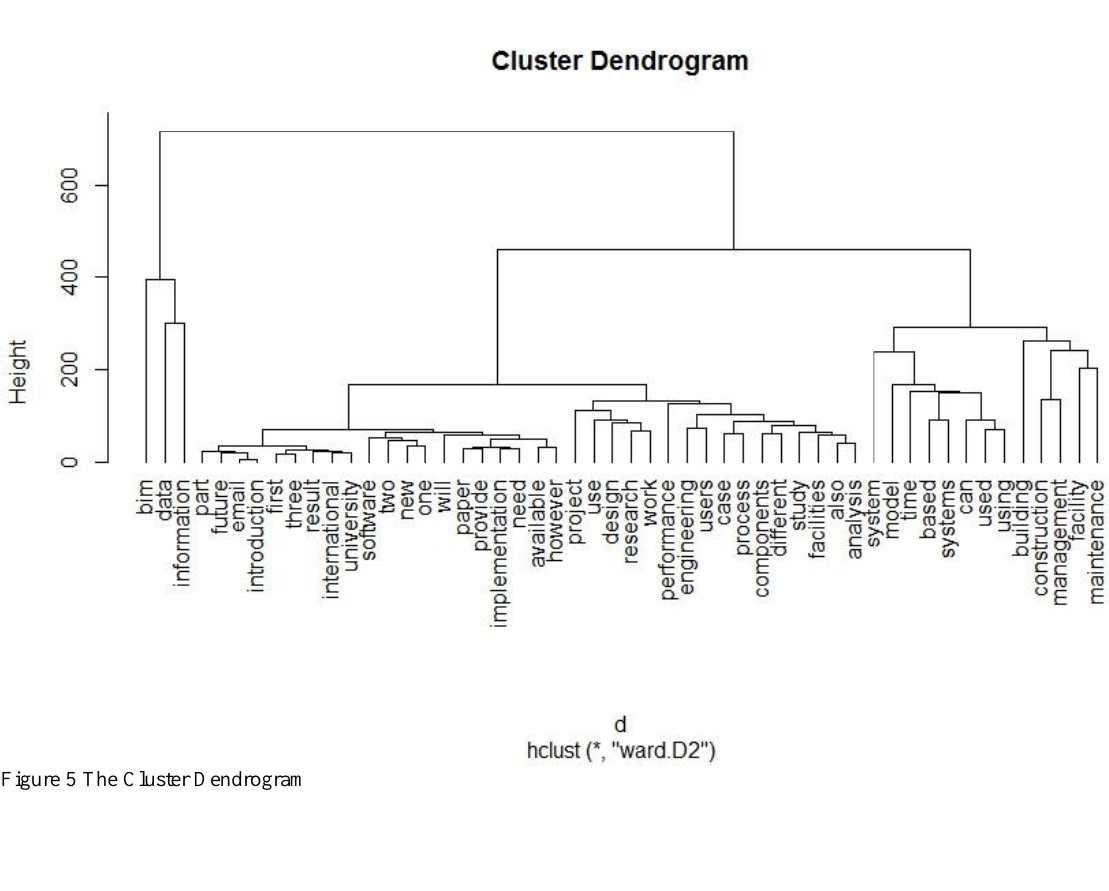
Figure 5 The Cluster